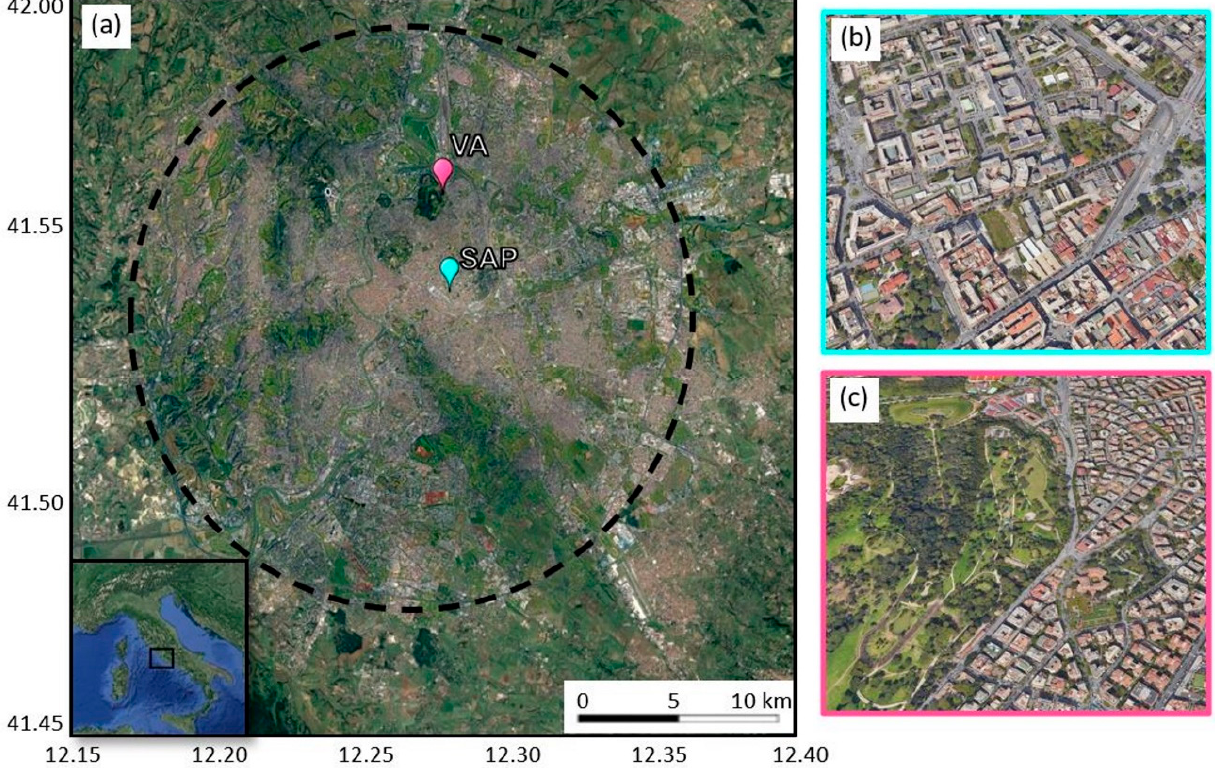
Figure 1. ( a ) Geographical map of the area under investigation. The black dashed line depicts the urban center of Rome, and cyan and magenta markers show the positions of the Sapienza (SAP) and Villa Ada (VA) stations. ( b ) Aerial photograph of the area surrounding Sapienza (SAP). ( c ) Aerial photograph of the area surrounding Villa Ada (VA).